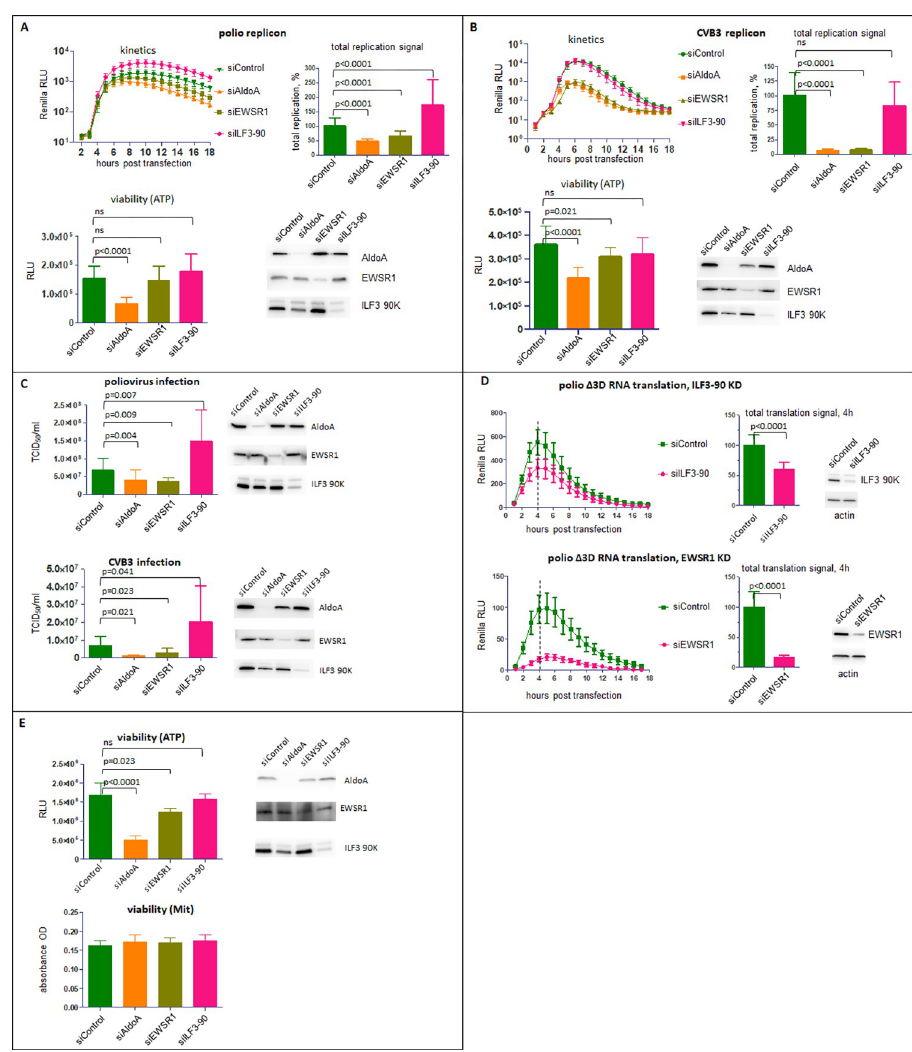
Fig 5. Effects of siRNA-mediated knockdown of expression of AldoA, EWSR1 and ILF3-90 on enterovirus replication. A, B. HeLa cells were transfected with siRNAs specific to AldoA, EWSR1 and 90KDa isoform of ILF3, or non-targeting control siRNA, and polio or Coxsakie B3 replicon replication assays were performed 72 h post siRNA transfection. The total replication signal was calculated as the area under the corresponding kinetics curves. Cell viability signal is proportional to the level of ATP in cells. Western blots show the efficacy of siRNA-mediated knockdown of the targeted proteins. C. HeLa cells were transfected with siRNAs specific to AldoA, EWSR1 and 90KDa isoform of ILF3, or non-targeting control siRNA. 72 h post siRNA transfection cells were infected with an MOI of 1 PFU/cell of poliovirus or Coxsackie virus B3, and the total virus yield was determined at 6 h p. i. Western blots show the efficacy of siRNA-mediated knockdown of the targeted proteins. D. HeLa cells were transfected with siRNAs specific to 90KDa isoform of ILF3 or EWSR1 or a non-targeting control siRNA. 72h post siRNA transfection, the cells were transfected with a replication-defective replicon RNA containing the Δ 3D mutation. The total translation signal was calculated as the area ander the curve from 1 to 4 h post Δ 3D RNA transfection. Western blots show the efficacy of siRNA-mediated knockdown of the targeted proteins. E. HeLa cells were transfected with siRNAs specific to AldoA, EWSR1 and 90KDa isoform of ILF3, or non-targeting control siRNA, and cell viability assays detecting the level of ATP or the activity of the mitochondrial respiratory chain enzymes were performed 72h post siRNA transfection. Western blots show the efficacy of siRNA-mediated knockdown of the targeted proteins.